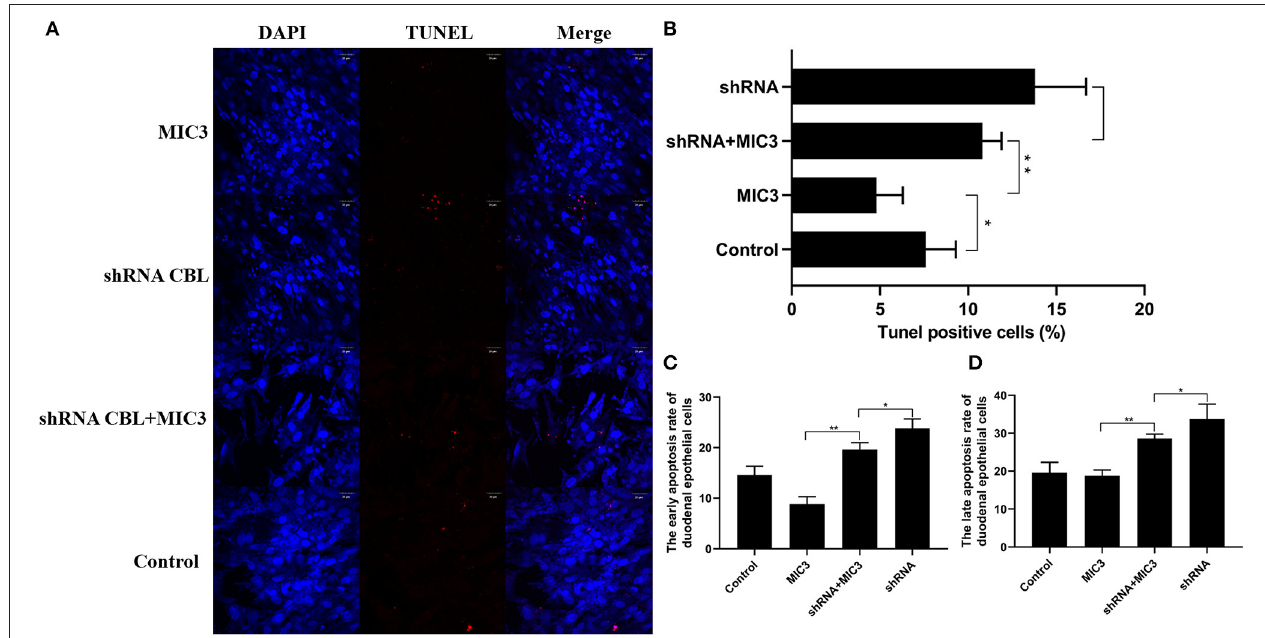
FIGURE 5 | The inhibitory effect of MIC3 protein on the apoptosis of chick duodenal epithelial cells through targeting CBL. (A) The observation of emitted red fluorescence under the fluorescence microscope showing the apoptosis rate of chick duodenal epithelial cells in the control, CBL shRNA, CBL shRNA + MIC3, and MIC3 groups by TUNEL assay. (B) Quantitative analysis of the TUNEL positive cells in the control group, the CBL shRNA group, CBL shRNA + MIC3, and the MIC3 groups by TUNEL assay ( n = 3). (C) Quantitative analysis of the early apoptosis rate of chick duodenal epithelial cells in the control, CBL shRNA, CBL shRNA + MIC3, and MIC3 groups by Annexin V-FITC/PI apoptosis kit assay ( n = 3). “ ** ” represents the apoptotic rate of host cells in MIC3 group was significantly lower than that in the shRNA + MIC3 group ( + P < 0.01). “ * ” represents the apoptotic rate of host cells in shRNA + MIC3 group was significantly lower than that in shRNA group ( + P <